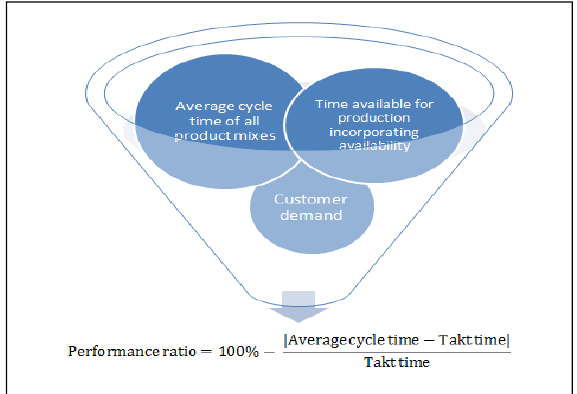
Figure 2. Performance ratio defined in this study and its